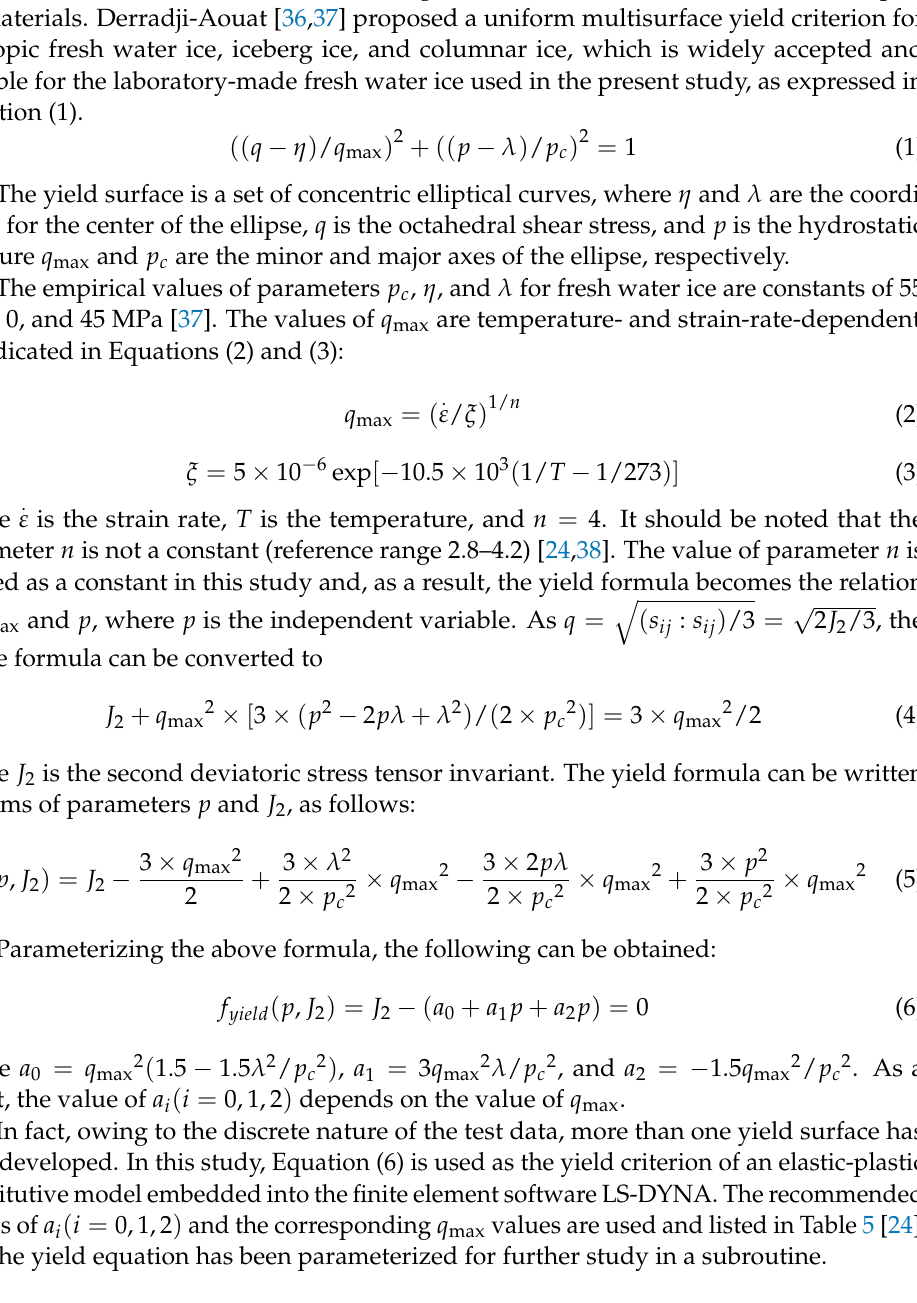
Table 5. Values of a i ( i = 0,1,2 ) and q max